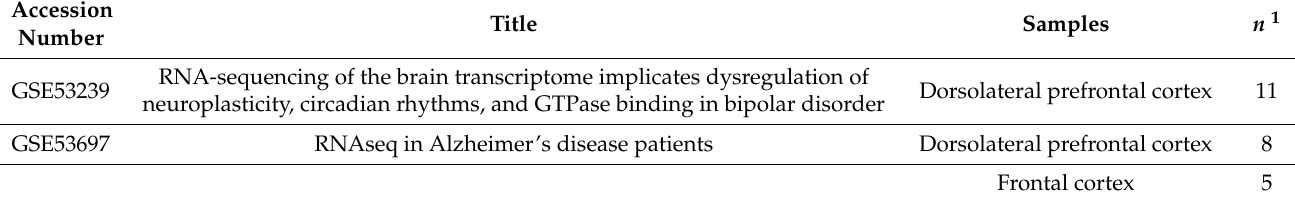
Human brain tissues from healthy controls and multiple sclerosis patients